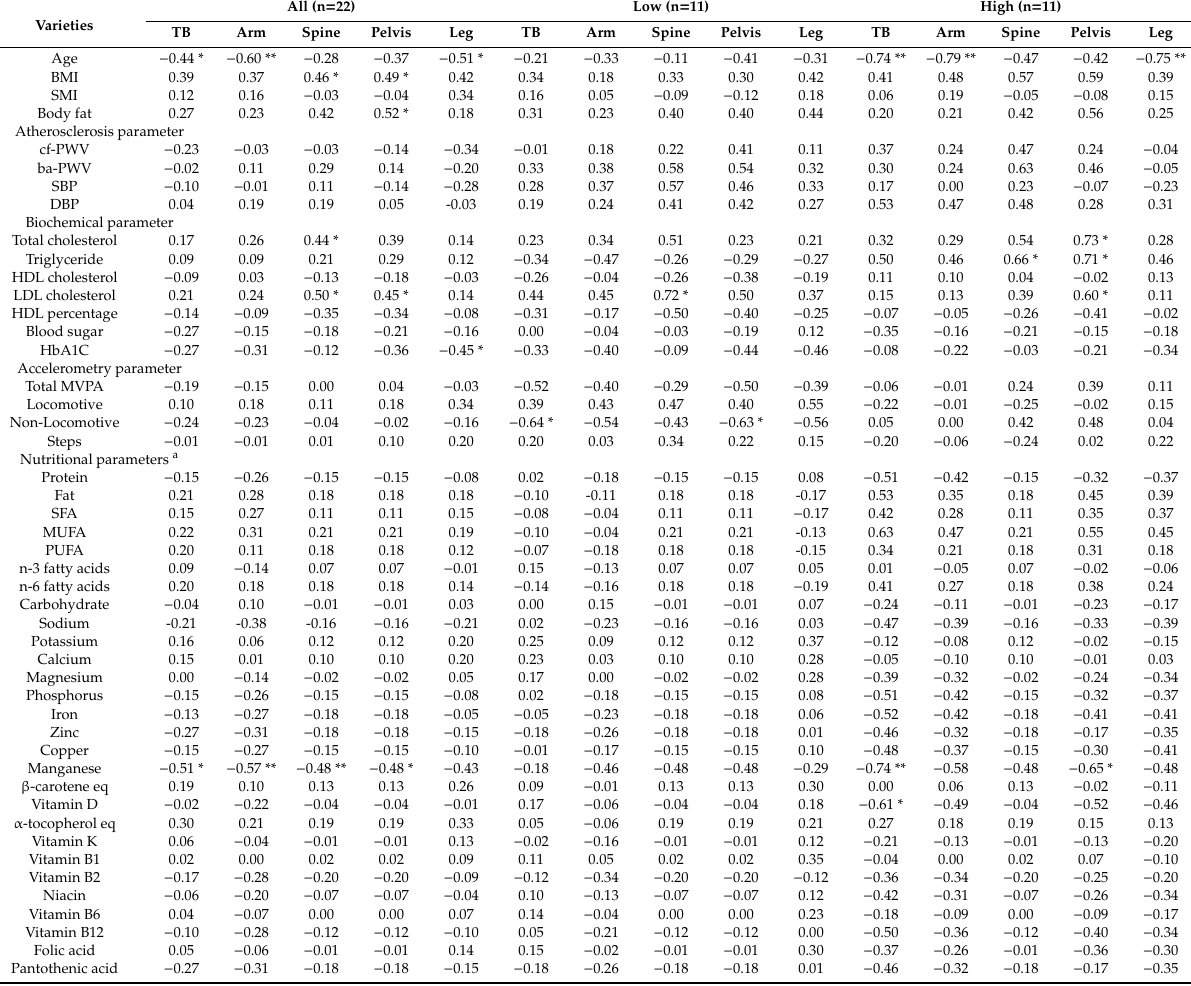
Table 4. Correlation coe ffi cients between analysed characteristics variables and bone mineral